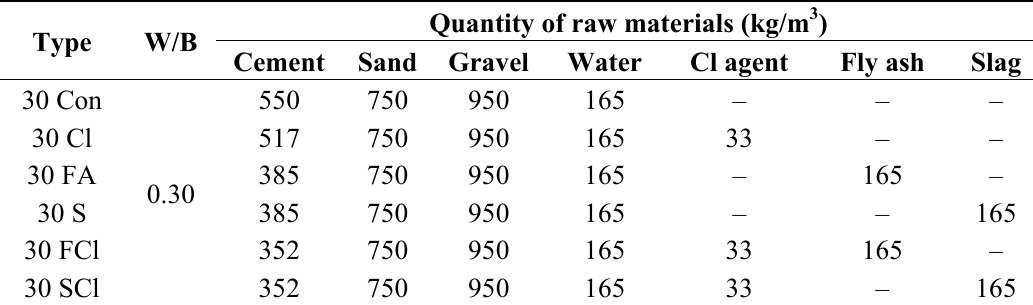
Table 4. Mix proportions and 28-day strength (MPa) of